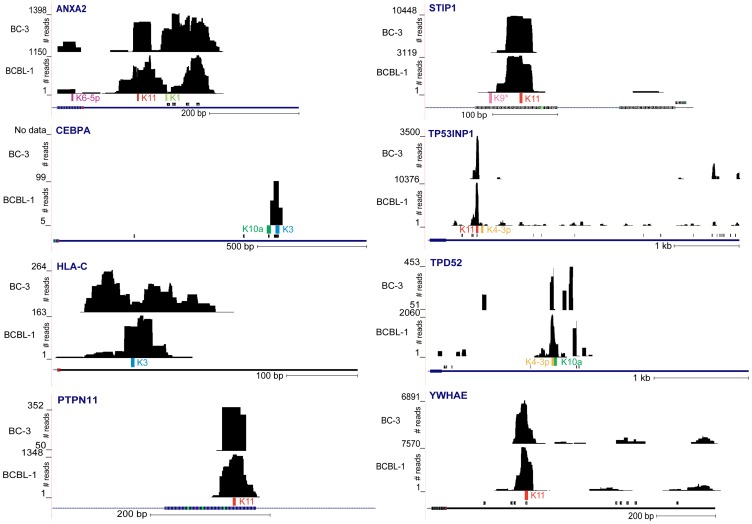
Ago-miRNA-mRNA clusters in new KSHV miRNA targets identified by Ago HITS-CLIP.mRNA-derived clusters of reads are visualized in UCSC genome browser as wiggle tracks. Shown are the positions of read clusters overlapping with miRNA seed match sites within 3′UTRs and exons of target transcripts in BCBL-1 and BC-3. KSHV miRNA seed match positions are indicated by colored bars; those of human miRNAs as predicted by TargetScan (for 3′UTRs only) are shown as black bars. Note that in BCBL-1 the major peak of TPD52 with the two KSHV miRNA seed match sites overlaps with several smaller peaks, resulting in a total cluster width of 340 nts. Therefore, for BCBL-1, TPD52 is listed in the ‘wide cluster’ list (Table S3C).